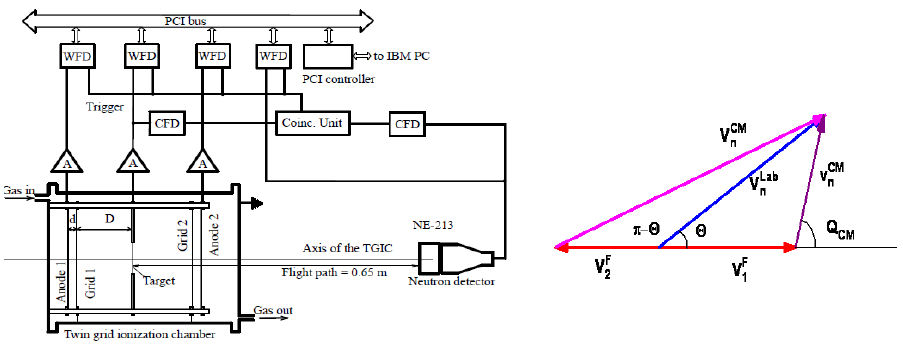
Fig. 1. Experimental setup(left) . Vector diagram for PFN emission from FF